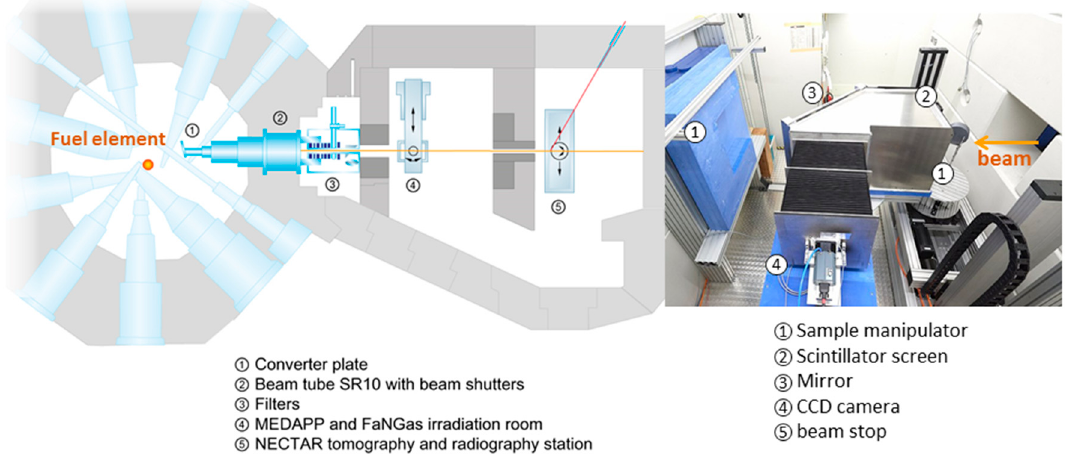
Figure 1. Localization of the instrument NECTAR at the FRM II reactor and a photograph of the detection setup (adapted from [10]).